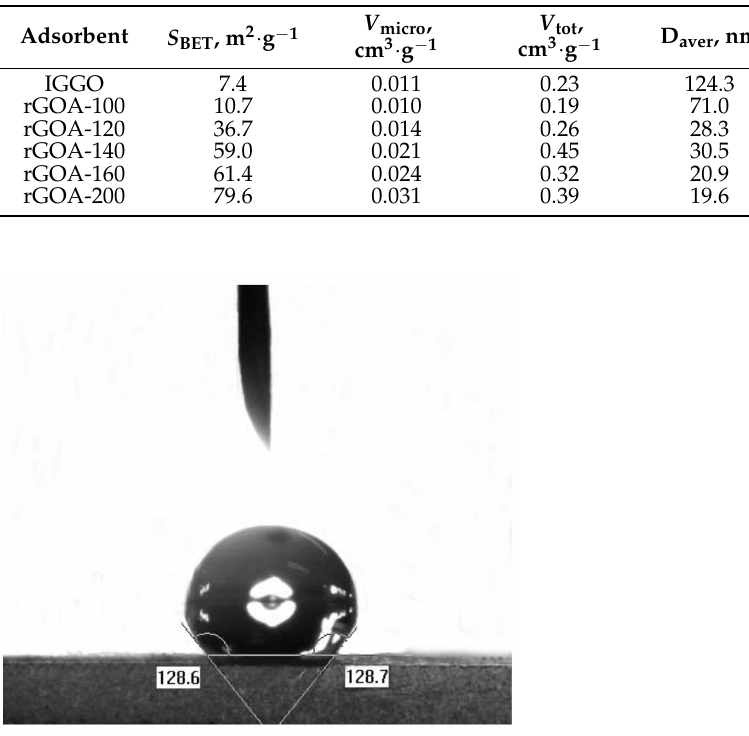
Figure 3. Image showing a water droplet on the surface of an rGOA-200